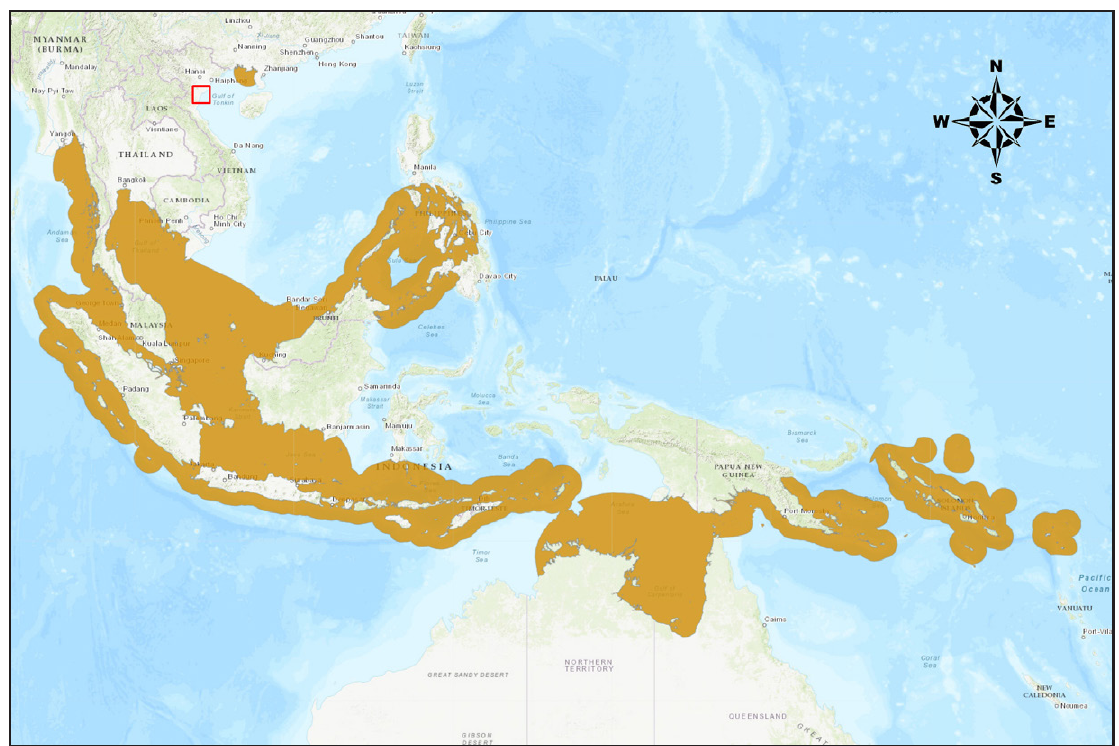
Figure 1. Distribution of Nemipterus marginatus . The yellow area is distribution of this species according to IUCN (2019). The red square is new